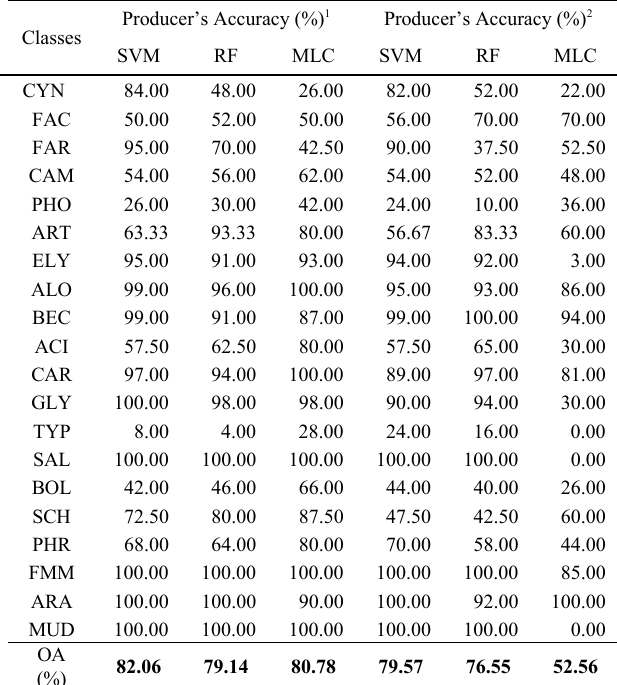
Table 3. Producer’s accuracy (%) of the classes using SVM, MLC and RF classifiers with 9 MNF-transformed bands and 30 (1) and 10 (2) random training